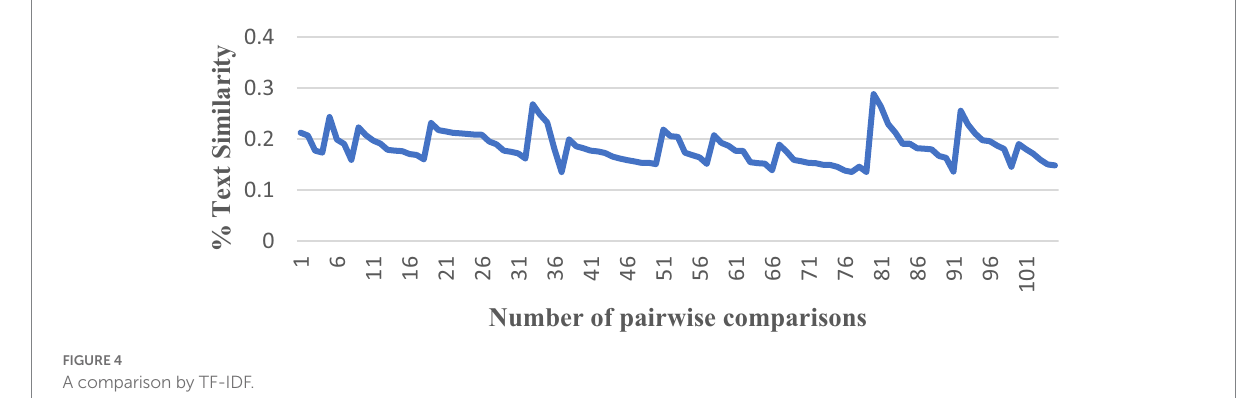
FIGURE 4 A comparison by TF-IDF.